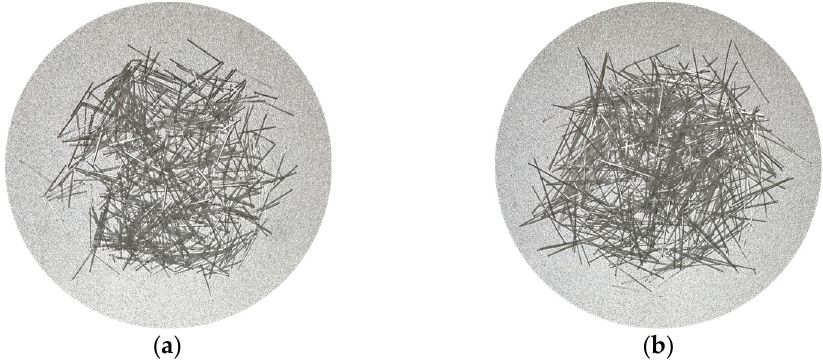
Figure 5. The photo of POM fiber: ( a ) 6 mm POM fiber; ( b ) 12 mm POM fiber.